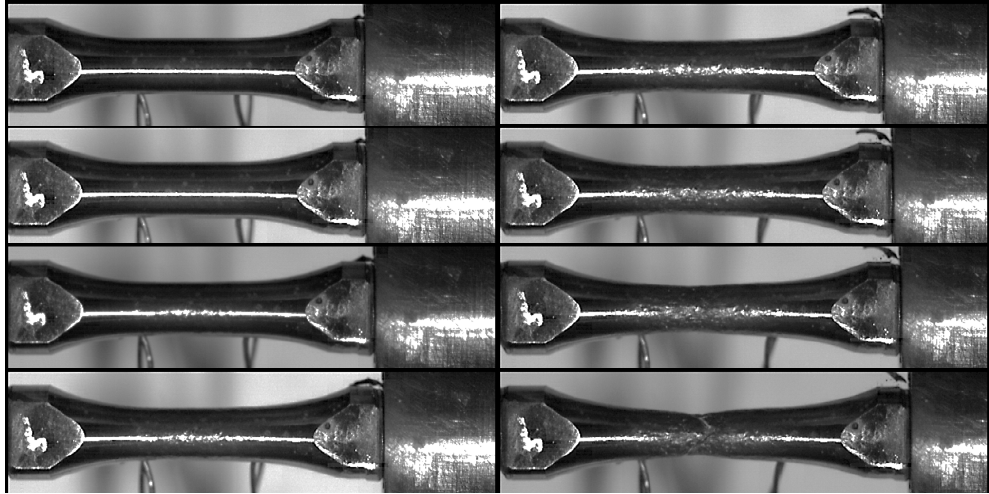
Figure 3. Sequence of images of a high strain rate test at 850°C on an HT specimen: resolution of 52 × 128 pixels, framerate of 100,000 fps, shutter of 1/1,000,000 s, time interval between the reported images of 50 μ s.